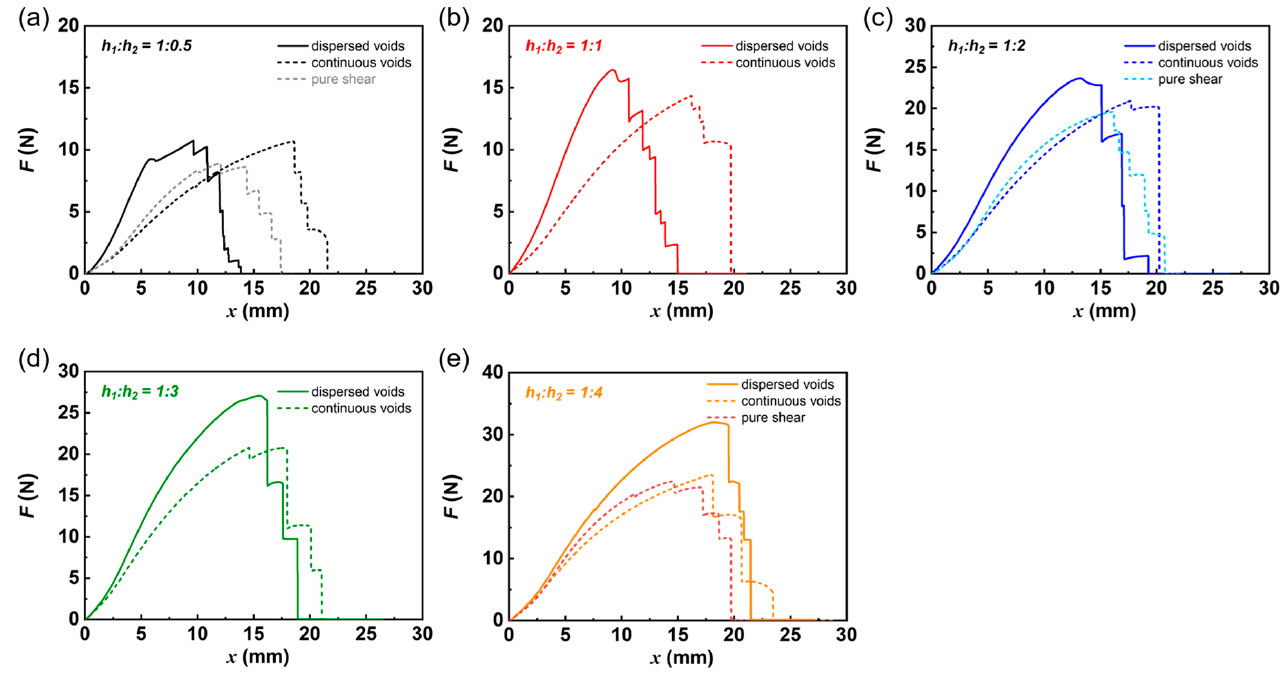
Figure 2. Representative force curves of highly deformable DN hydrogels under different structural models with dispersed cuts (D-cut gels) and continuous cuts (C-cut gels). The representative force ( F )–displacement ( x ) curves of DN hydrogels under different structural models containing dispersed cuts and continuous cuts at different spacing ratios h 1 : h 2 of 1:0.5 ( a ), 1:1 ( b ), 1:2 ( c ), 1:3 ( d ), and 1:4 ( e ). The force curves of samples with a pure shear geometry were also provided in ( a , c , e ) for comparison.